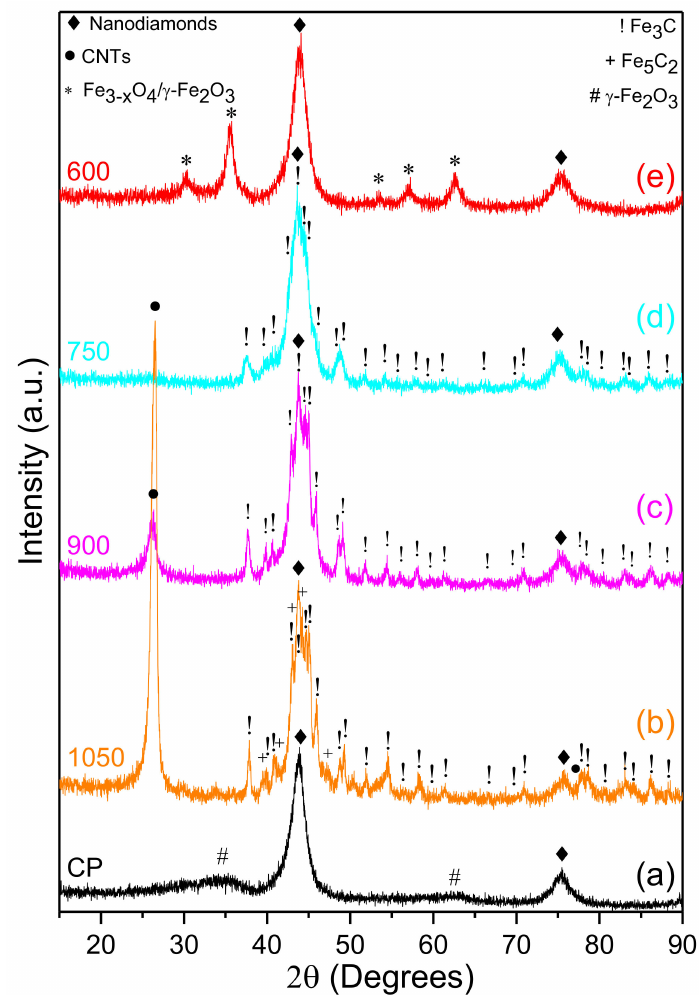
Figure 2. XRD patterns of the CP ( a ) and the NHDs samples resulting by annealing the CP at di ff erent temperatures indicated (in ◦ C): 1050 ( b ), 900 ( c ), 750 ( d ) and 600 ( e ). The presence of the di ff erent crystalline phases in the samples is denoted by the relative symbols on their di ff raction